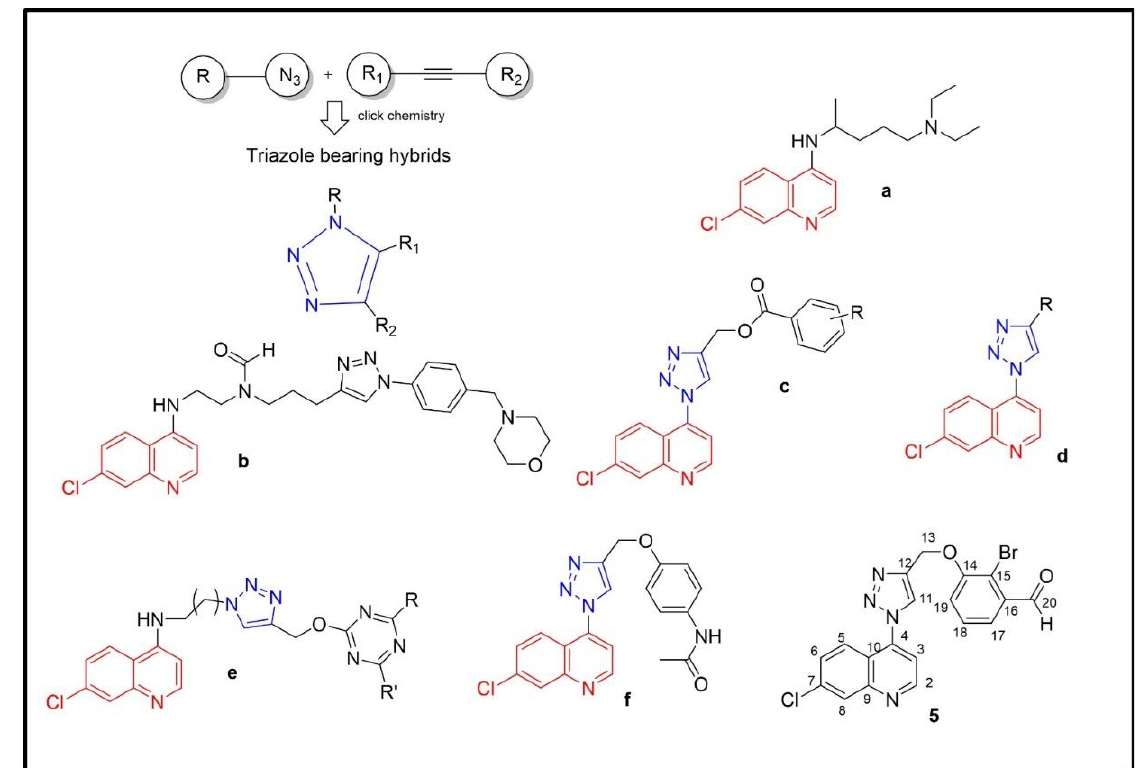
Figure 1. Clinically approved quinoline (red) and 1,2,3-triazole (blue) containing drugs (some structures of quinolone- and triazole-based hybrids reported in the literature ( a – g ) [9 – 14]); and the structure of the compound (cyan, 5 ) reported in this paper. Square: synthesis of 1,2,3-triazoles using click chemistry.